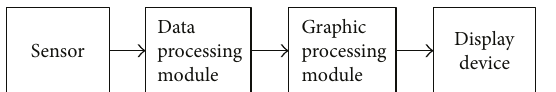
Figure 12: The experiment method.